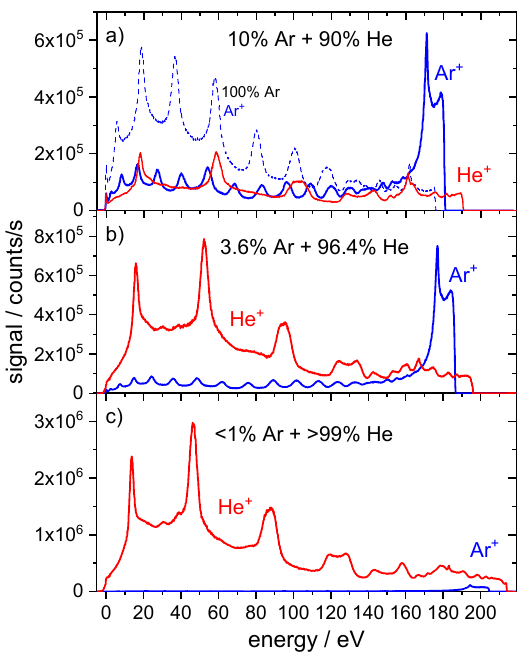
Figure 5. IEDFs of Ar + and He + measured at several Ar/He gas mixtures at gas pressure of 2.5 Pa and applied voltage of 300 V pp